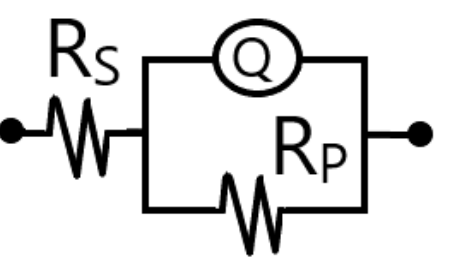
Figure 12. Equivalent circuit model used to fit the EIS experimental data. Table 3. EIS parameters obtained by fitting the impedance data for iron in chloride solutions with and without HAO molecules.